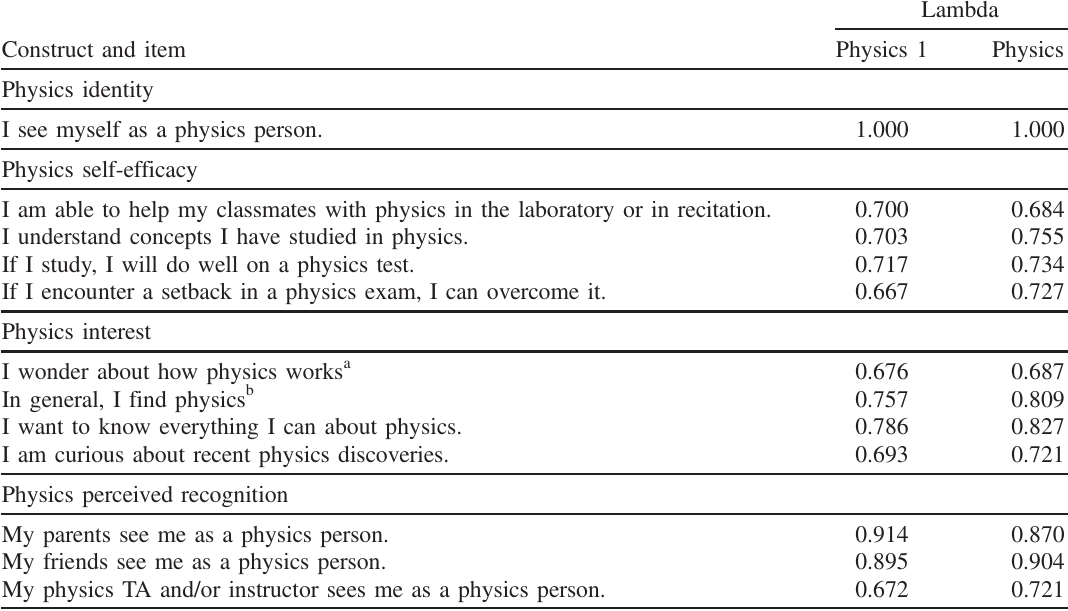
TABLE I. Survey questions for each of the motivational constructs, along with CFA factor loadings for physics 1 and physics 2. Lambda (factor loading) represents the correlation between each item and its corresponding construct, and the square of Lambda for each item gives the fraction of its variance explained by the construct. All Lambdas shown in this table are statistically significant with p value < 0 . 001